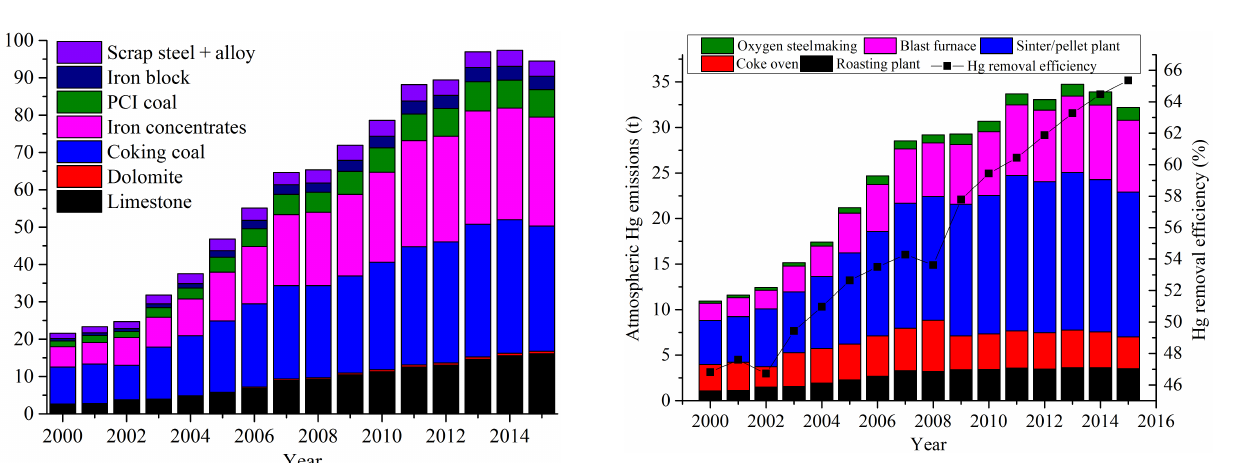
Figure 2. Hg input trends by material.